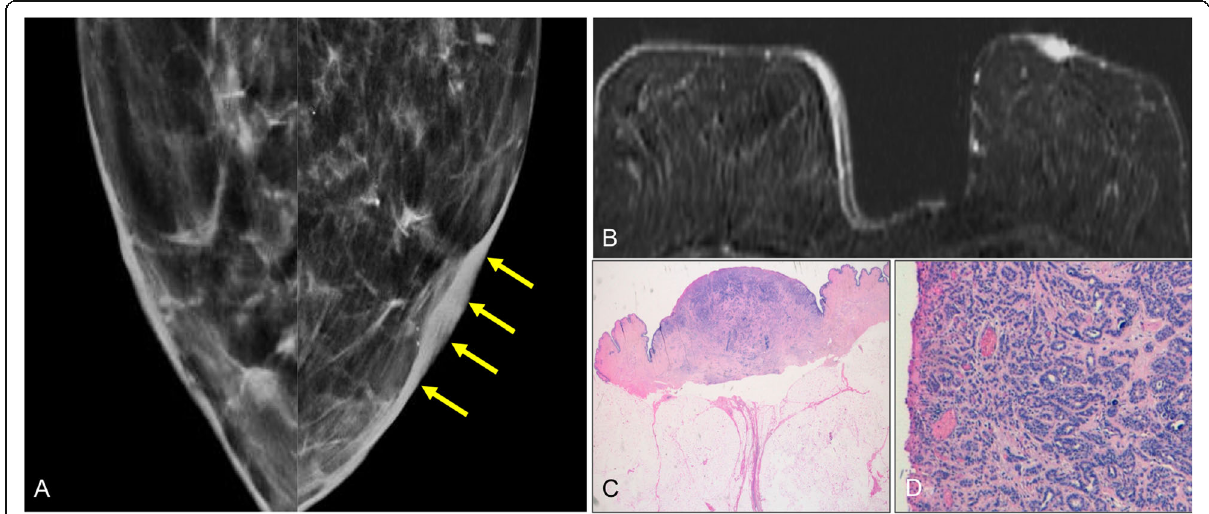
Fig. 33 Paget ’ s disease (II). An 81-year-old woman with an ulcerated lesion in her left nipple. a Synthesized 2D mammogram shows slight skin thickening in the left nipple-areolar complex (arrows). b MRI shows differential pathologic enhancement of the left nipple-areolar complex. c , d